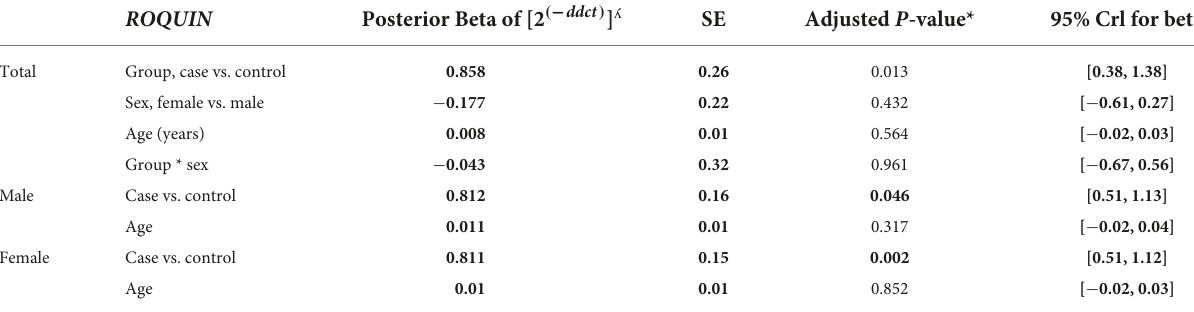
TABLE 5 Relative levels of ROQUIN in AD cases and controls according to the Bayesian quantile regression model. ROQUIN Posterior Beta of [2 ( − ddct ) ] SE Adjusted P -value* 95% Crl for beta Total Group, case vs. control 0.858 0.26 0.013 [0.38, 1.38] Sex, female vs. male − 0.177